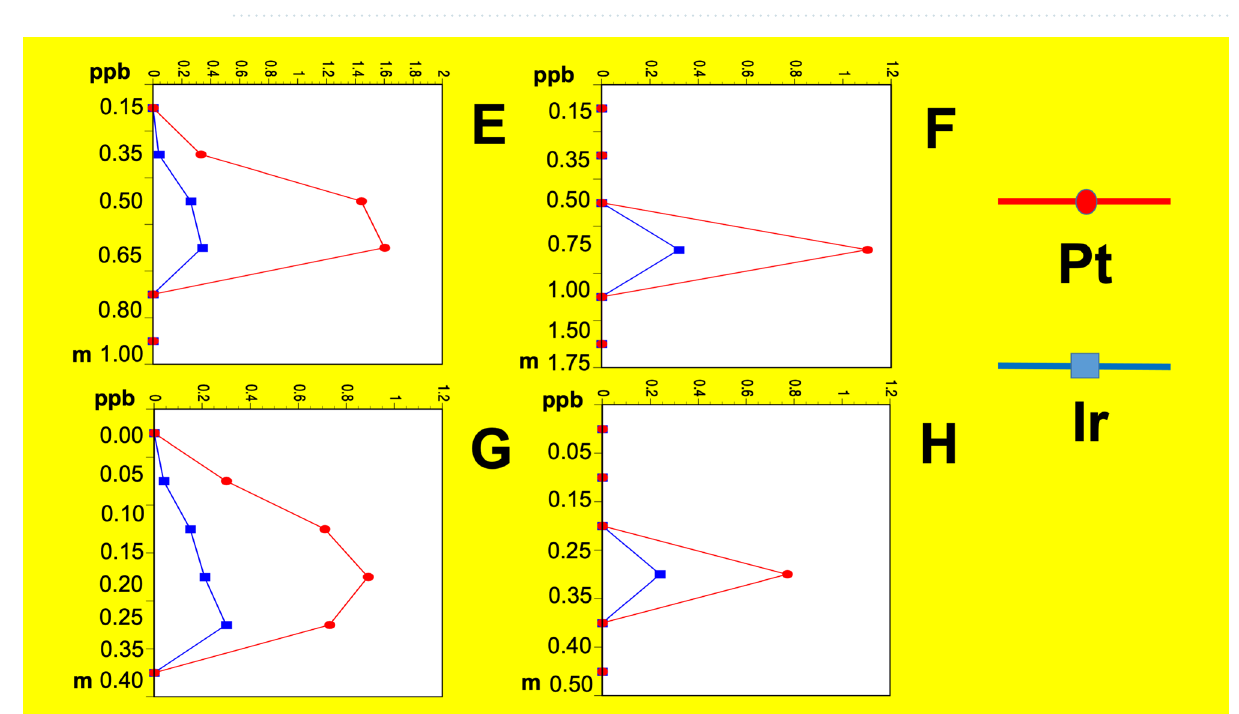
Figure 18. Positive Ir and Pt anomalies from the burned carbon-rich strata on Hopewell archaeological sites in the Ohio River valley: ( E ) Beech Tree village, Ohio; ( F ) Milford earthworks, Ohio; ( G ) Indian Fort Mountain earthworks, Kentucky; ( H ) Foster’s Crossing earthwork, Ohio. Kenneth Barnett Tankersley used Microsoft PowerPoint for Mac Version 16.41 (www. micro soft. com) to create this